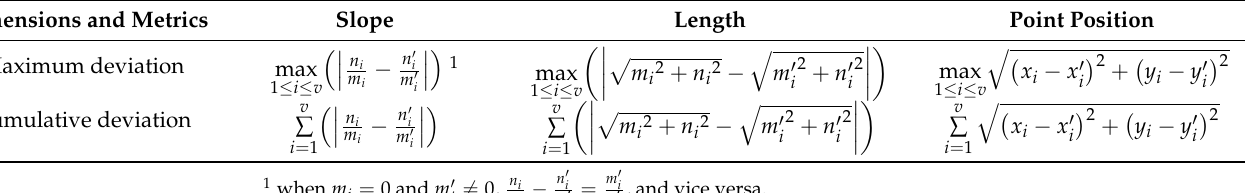
Table 4. The formula for calculating the similarity of each